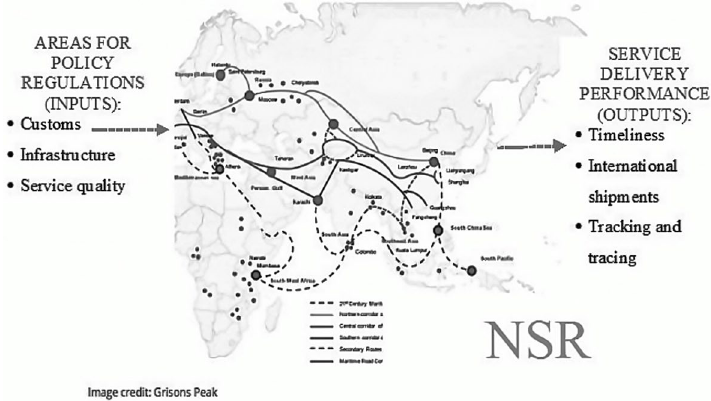
Fig. 4. Logistic performance index on the NSR